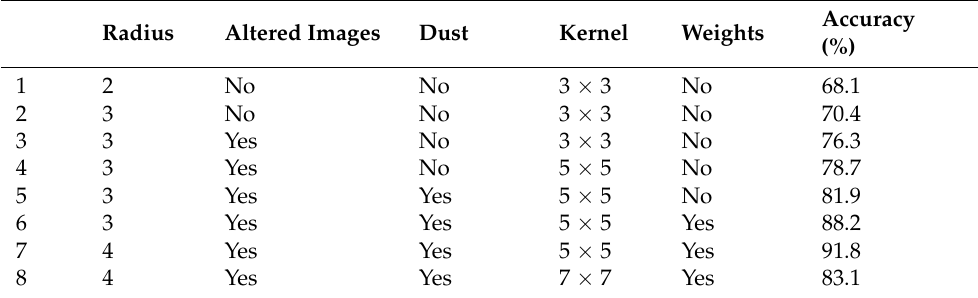
Table 2. Functional performance of the U-Net landmarks segmenter in detecting exactly 19 landmarks when variating a set of factors (Radius, Altered images, Dust, Kernel, Weights). Radius Altered Images Dust Kernel Weights